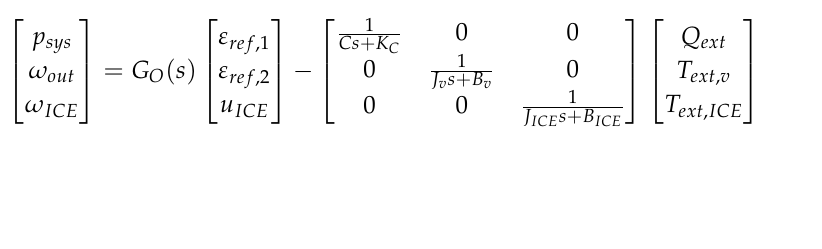
Figure 2. Block diagram of the linear model in Figure 1 at mode m , linearized at In the frequency domain, the model is described